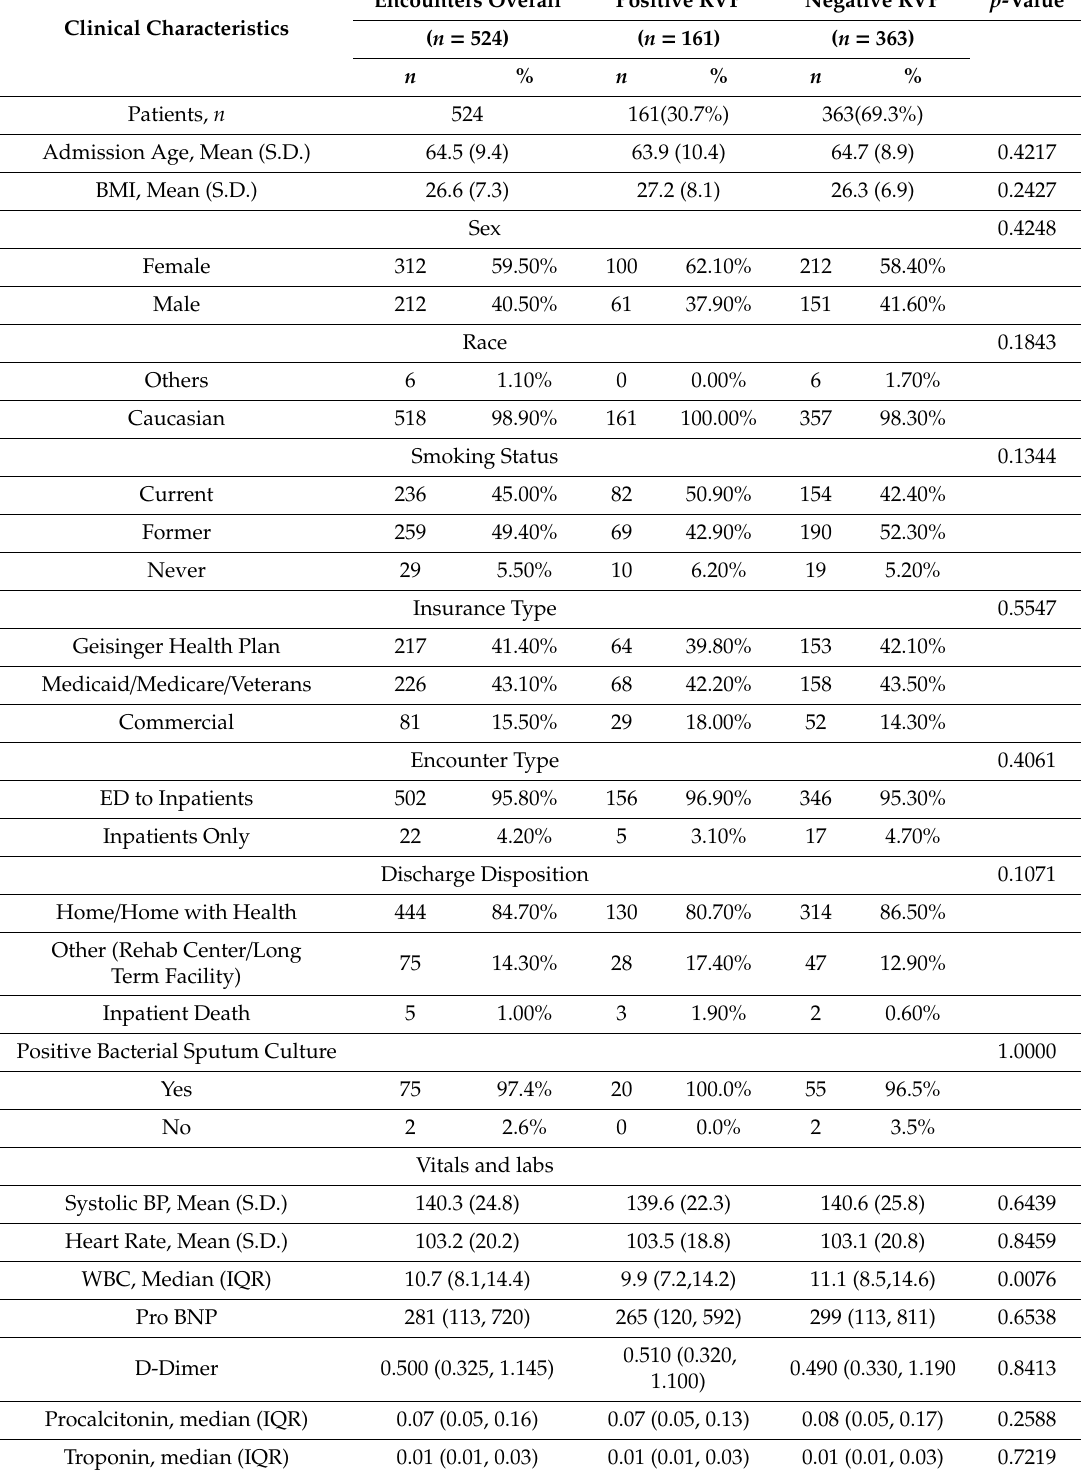
RVP = respiratory viral panel; S.D = standard deviations; BMI = body mass index; ED = emergency department; systolic BP = systolic blood pressure; WBC = white blood cells; IQR = interquartile ranges; pro BNP = pro brain natriuretic